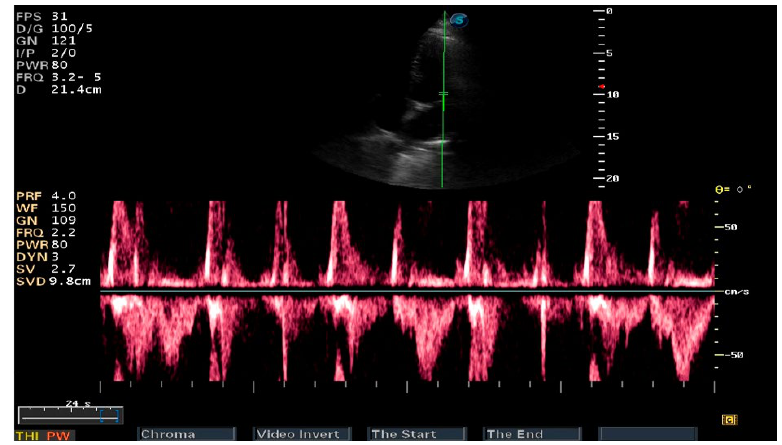
Figure 9. Case 3— TTE recording showing paroxysmal atrial fibrillation appeared at the time of A5C evaluation of mitral valve (A5C—apical 5 chamber).